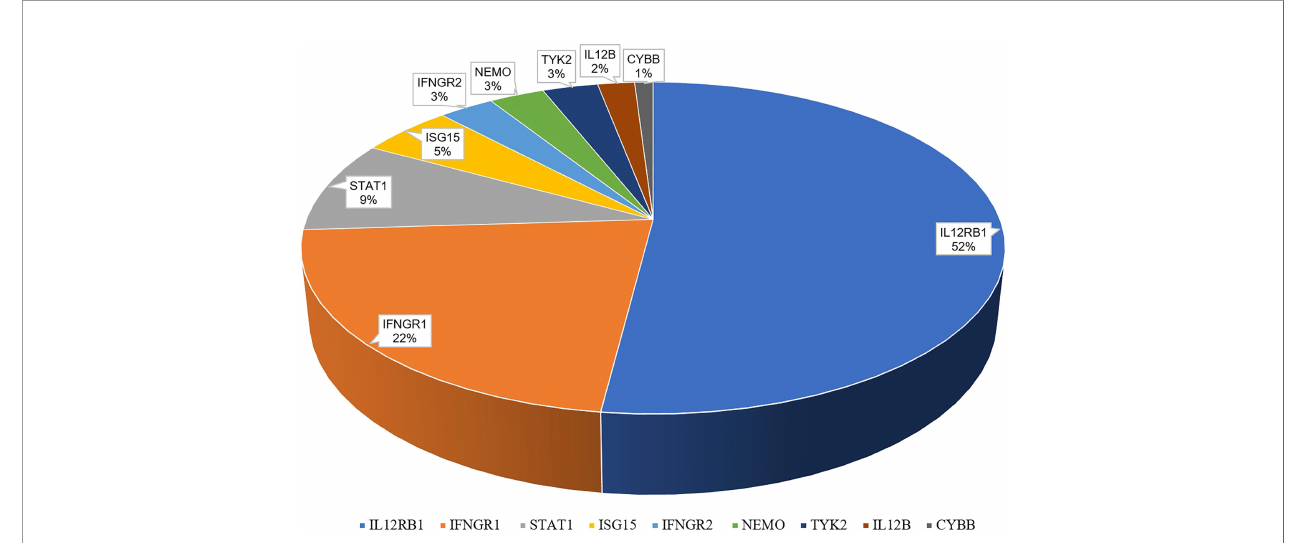
FIGURE 2 | Genetic mutations of 65 Chinese MSMD patients.